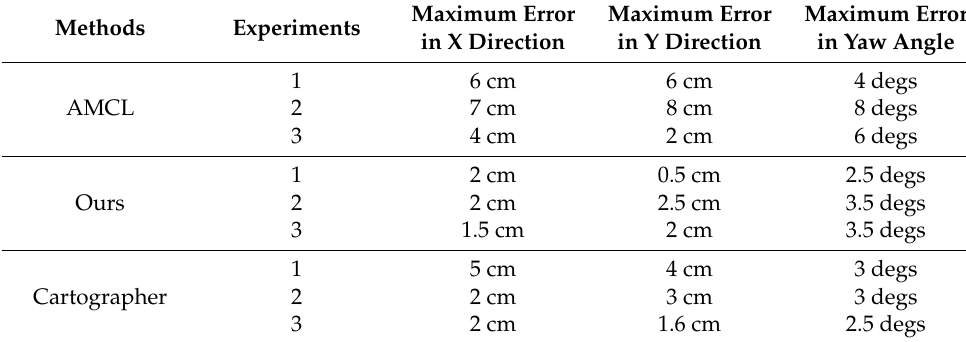
Table 1. Maximum positioning error in the simulation experiment of three algorithms. Maximum Methods Experiments